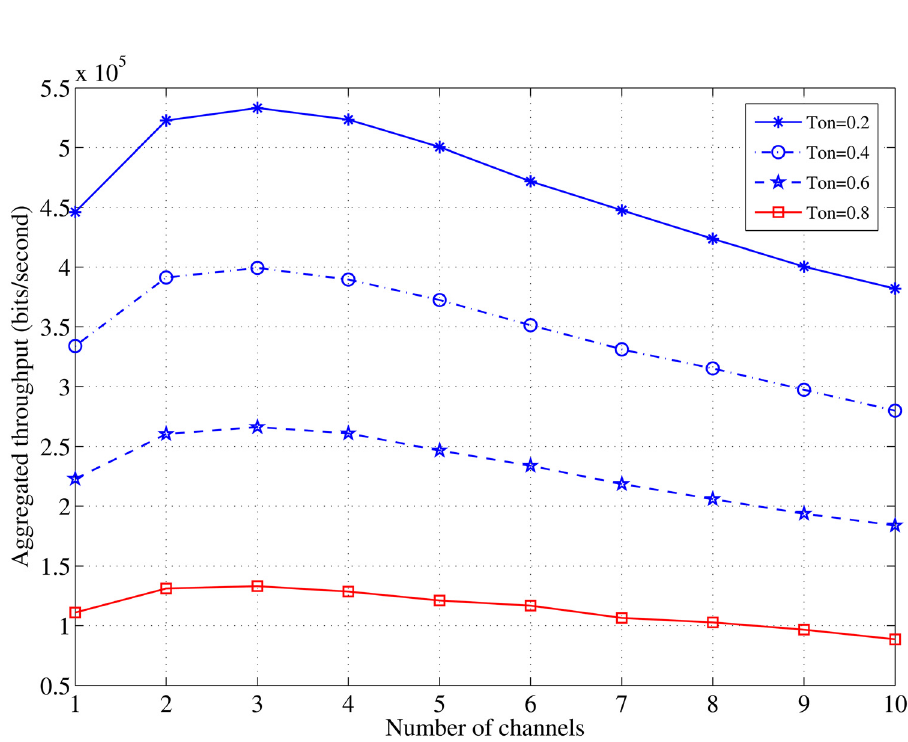
Fig 11. Relationship between C and the aggregated throughput in case of various values of τ off ; N = 10, L = 1000